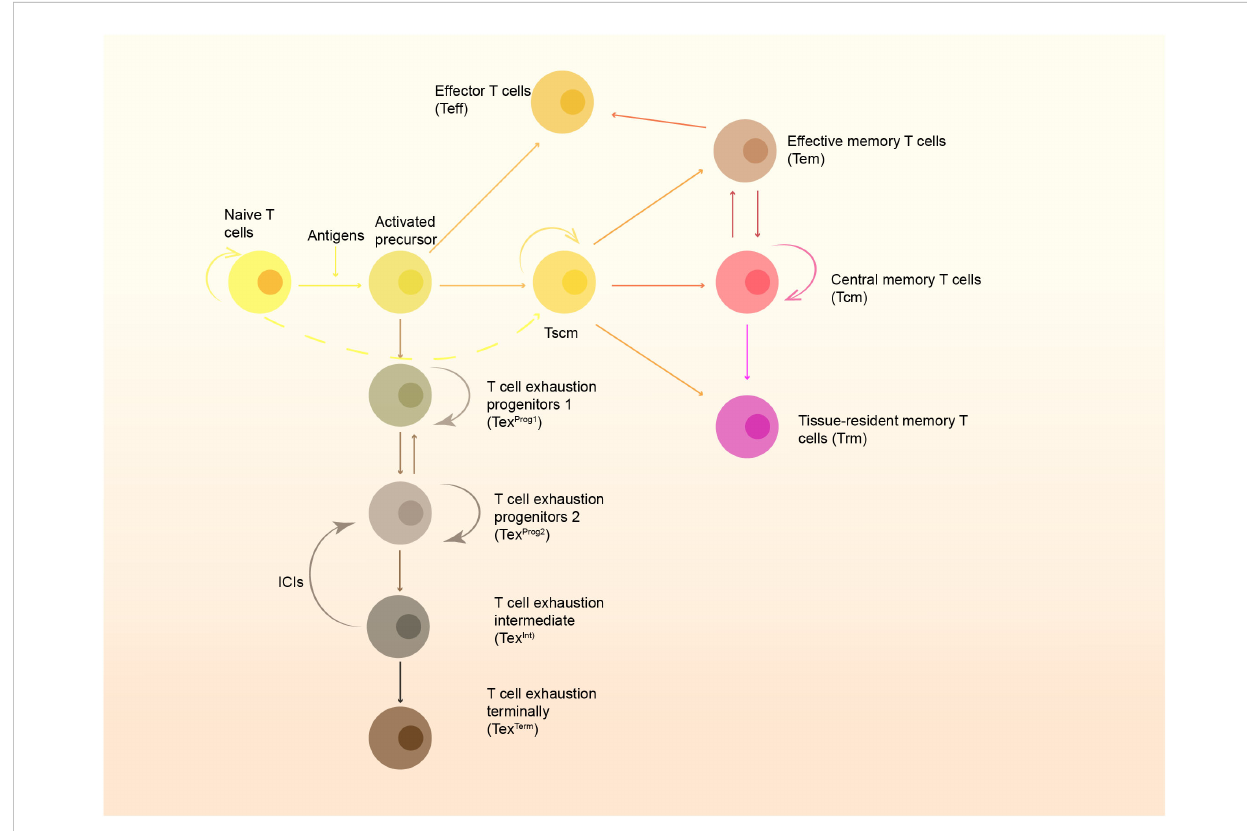
FIGURE 1 The formation of memory cells and the T cell exhaustion pathway. Naïve T cells are stimulated by antigens presented by APC and develop to active precursors, which further differentiate into effector T cells (Teff) and stem-like memory T cells (Tscm). Tscm can further develop to central memory T cells (Tcm), effector memory T cells (Tem) and tissue-resident memory T cells (Trm). Some of them can also become exhausted gradually, and restoration of function of these cells rely on immune checkpoint inhibitors